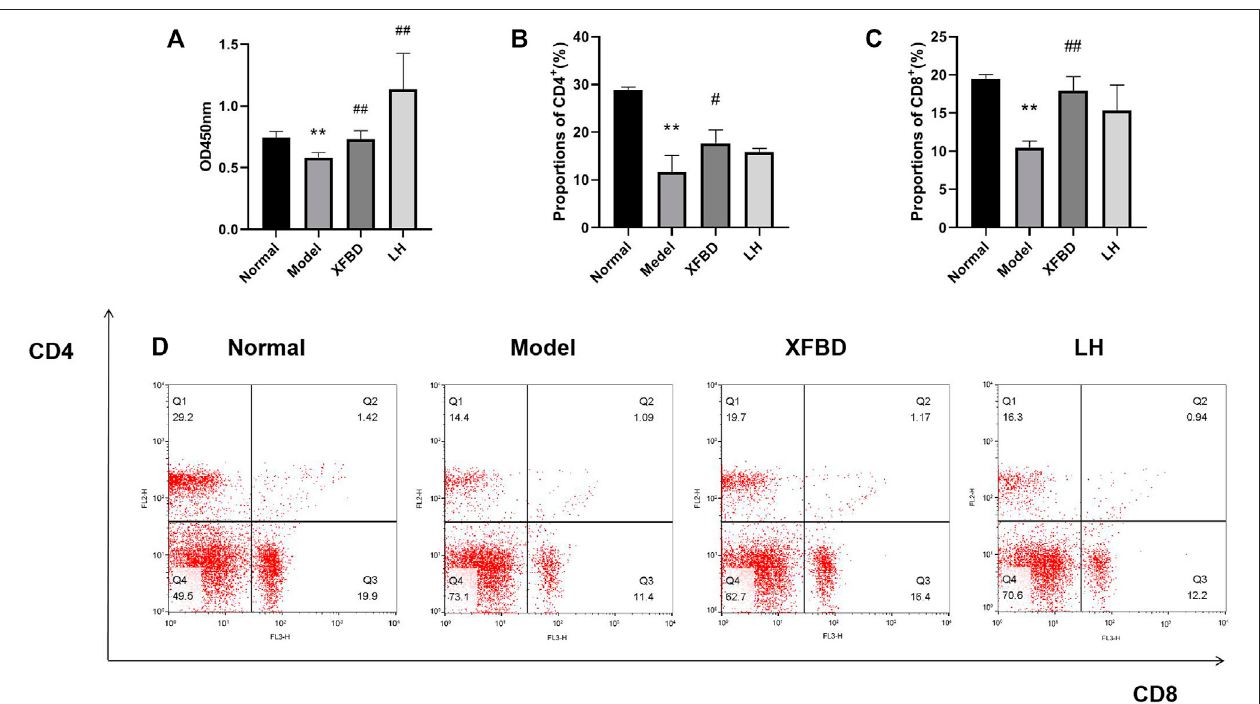
FIGURE 4 | Effects of XFBD on LPS-induced splenic lymphocyte proliferation and T lymphocyte subsets in CY-treated mice. (A) LPS-induced splenic lymphocyte proliferation; (B) representative fl ow cytometry analysis result of CD4 + subset; (C) representative fl ow cytometry analysis result of CD8 + subset; and (D) representative images of Splenic T lymphocyte subsets detected by fl ow cytometry. Normal, administered with saline; Model: intraperitoneally administered with cyclophosphamide; XFBD: intraperitoneally administered with cyclophosphamide fi rst and followed by XFBD at 3.9 g/kg/day; and LH: intraperitoneally administered with cyclophosphamide fi rstandfollowedbyLHat20 mg/kg.Dataareexpressedasmean ± SD( n (cid:2) 3).* p < 0.05and** p < 0.01vs.Normalgroup,# p < 0.05and## p < 0.01 vs. Model